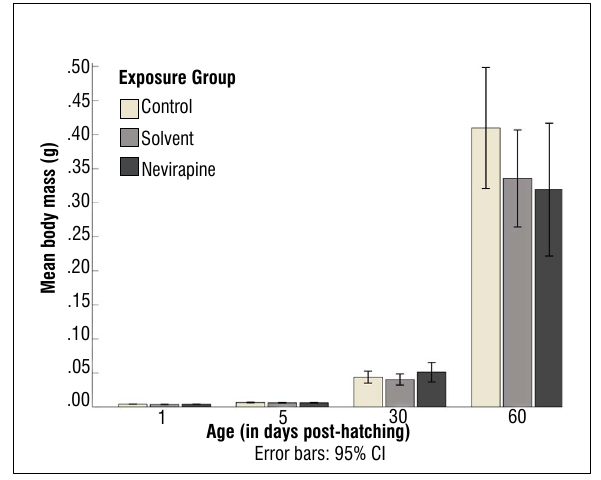
Mean condition factor of fish in all three exposure groups from Day 1 to Day 60